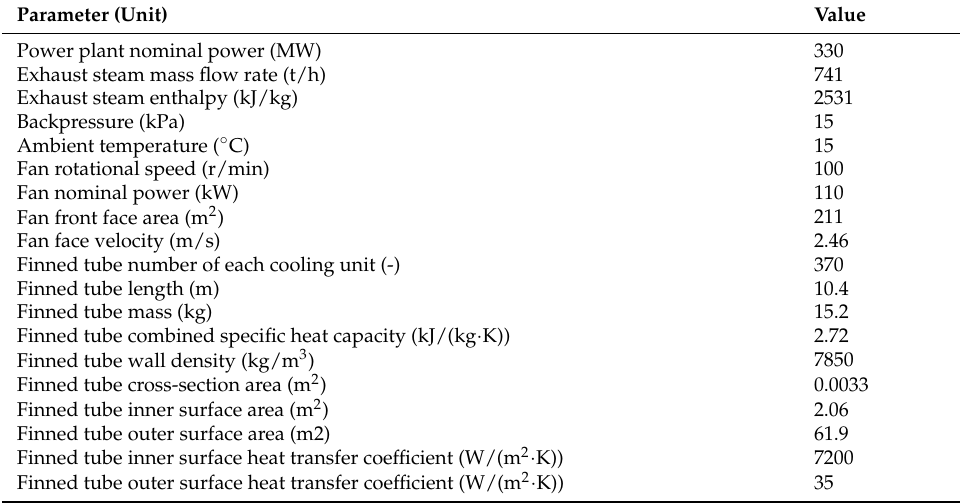
Figure 1. The schematic of the cold-end system. Table 1. The Designed Parameters of the Direct Air-Cooling Condenser.